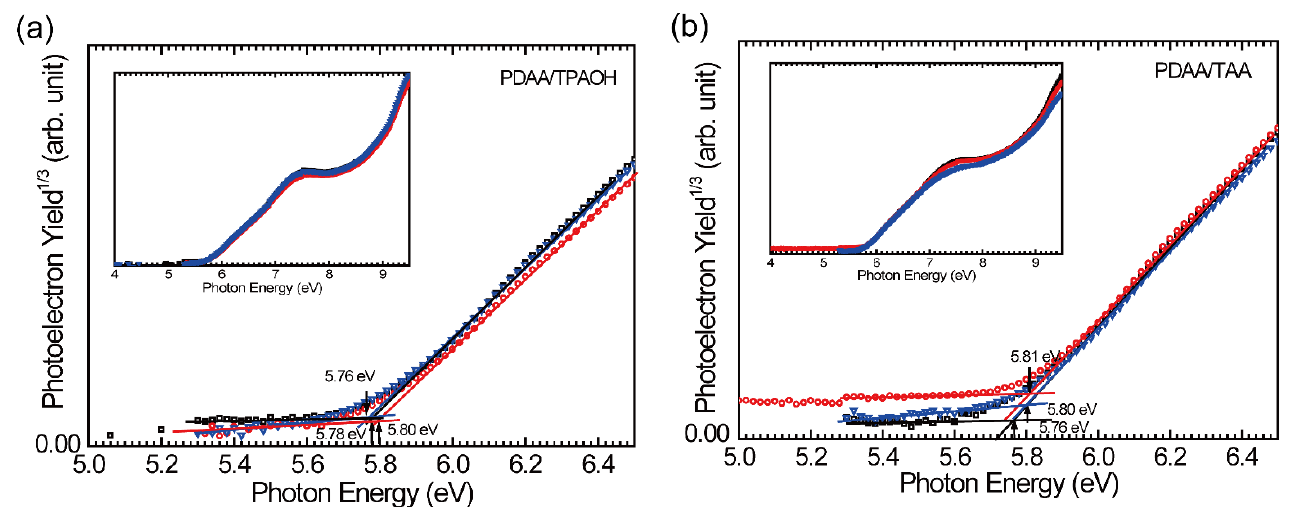
Figure 2. Plots of photoelectron yield as a function of incidence photon energy for ( a ) PDAA/TPAOH and ( b ) PDAA/TAA. Three times measurements were performed at different illumination positions for each sample. Each measurement is separately shown by black, red, and blue plots. Black arrows and numerals indicate the ionization potential for each sample.